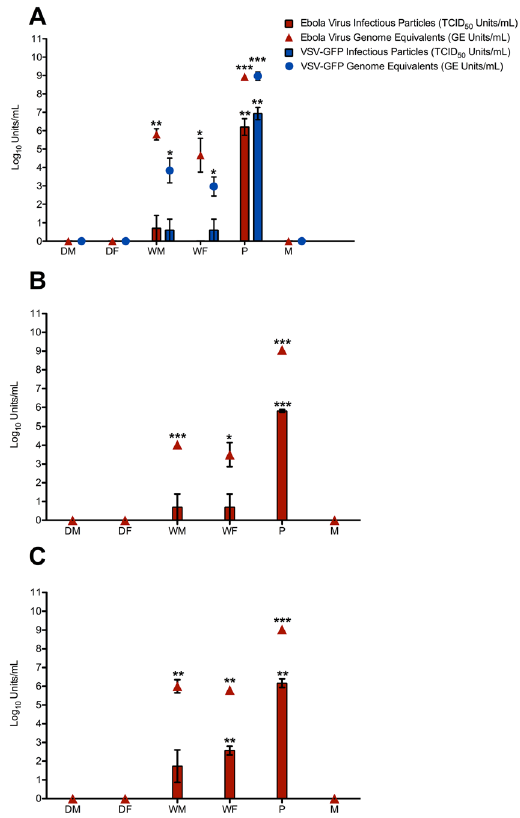
Figure 3. Ebola or VSV-GFP virus penetration through a surgical mask and N95 respirators challenged in dry and saturated conditions. Whole masks were fitted onto the face of a respiratory mannequin and challenged with Ebola virus. The mannequin was programmed to breath for thirty minutes at 21.5 °C and 30–35% RH. The masks were then removed and the inside surface of the mask and face of the mannequin were dry swabbed to detect virus penetration: ( A ) surgical mask, ( B ) KC 200 N95 respirator, ( C ) KC 300 N95 respirator. An equal volume of virus used to challenge the masks was back titrated as a positive control. Recovery of vRNA but not infectious virus particles suggest that saturation of the examined masks compromised protection by 100%. Where: DM-dry mask, DF- dry face, WM- wet mask, WF- wet face, P-positive/inoculation control, M-mock. The Mask Penetration experiments were performed in three biological replicates, each consisting of three technical repetitions. Reported values are the average across all replicates (n = 9) error was calculated as standard error of the mean. A paired T-test was used to calculate significant differences in mean values between the test and negative control (P-value: not significant > 0.05, * ≤ 0.05, ** ≤ 0.01 and *** ≤